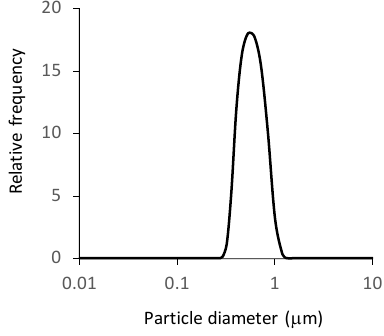
Figure 2. Particle size distribution of NG(S).